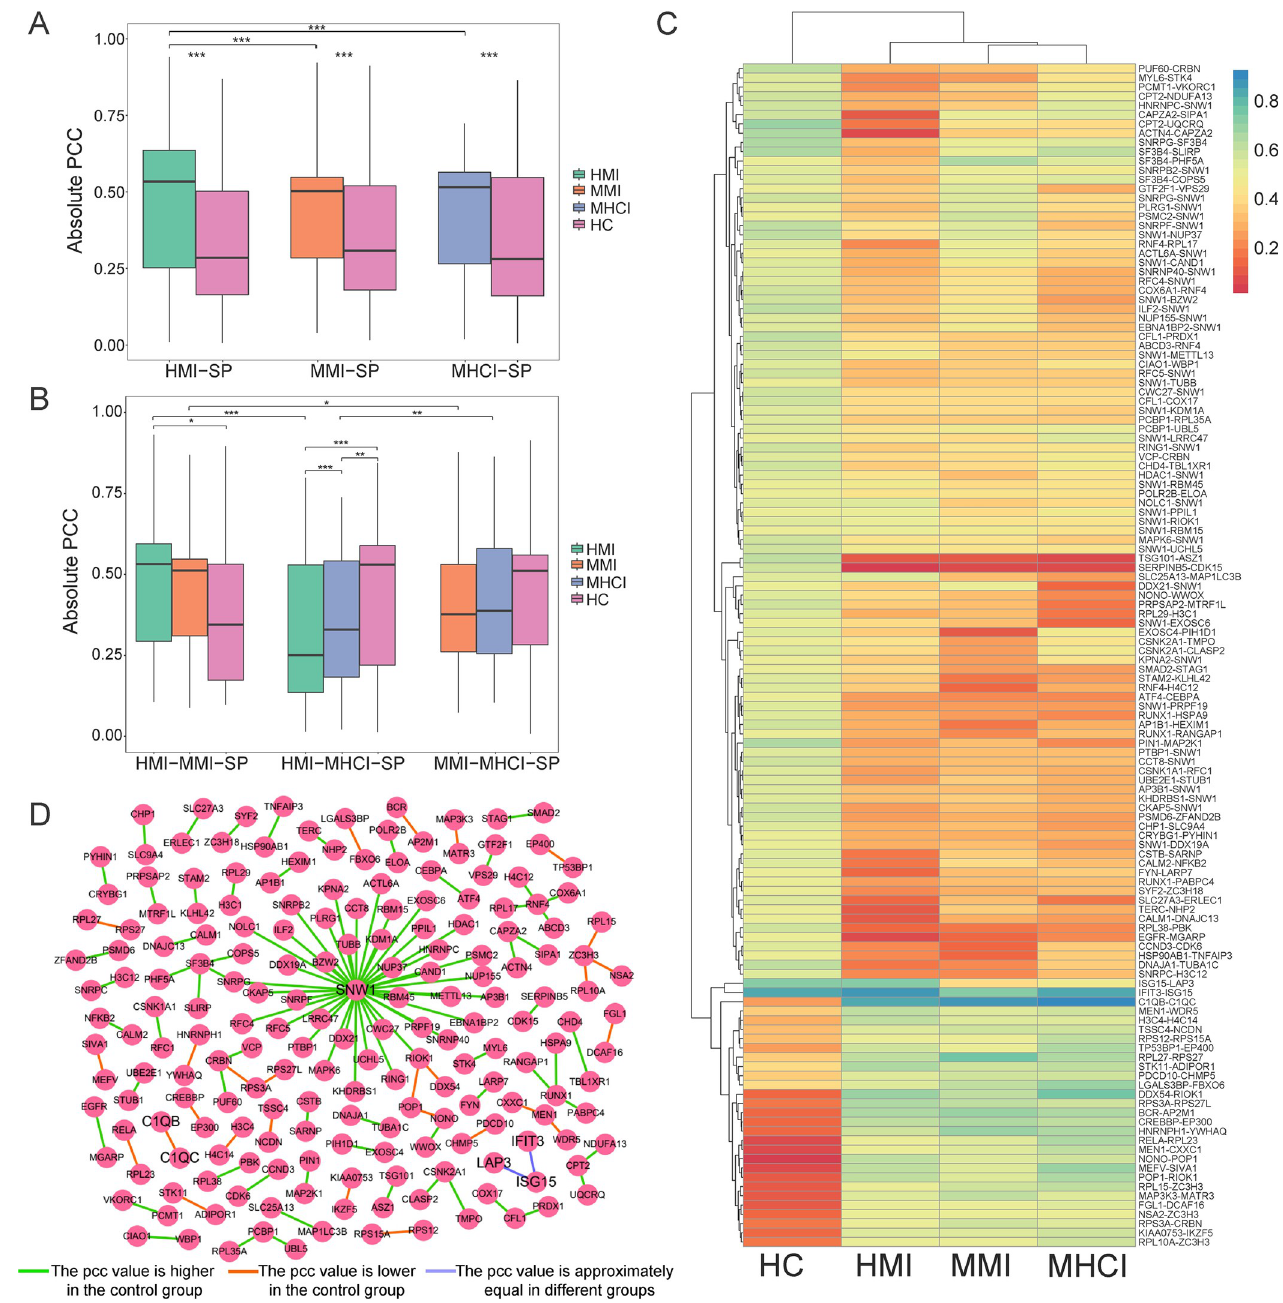
Fig 6. Expression correlations of disease-related gene pairs. (A) Absolute PCC values of specific gene pairs. (B) Absolute PCC values of gene pairs shared by two statuses. (C) Absolute PCC values of common gene pairs. (D) Network of common gene pairs. If the absolute PCC values are consistently greater than (or less than) 0.5 in different groups, the expression correlation of a gene pair is considered to be approximately equal. ��� P < 0.001, �� 0.001 � P < 0.01 and � 0.01 � P <